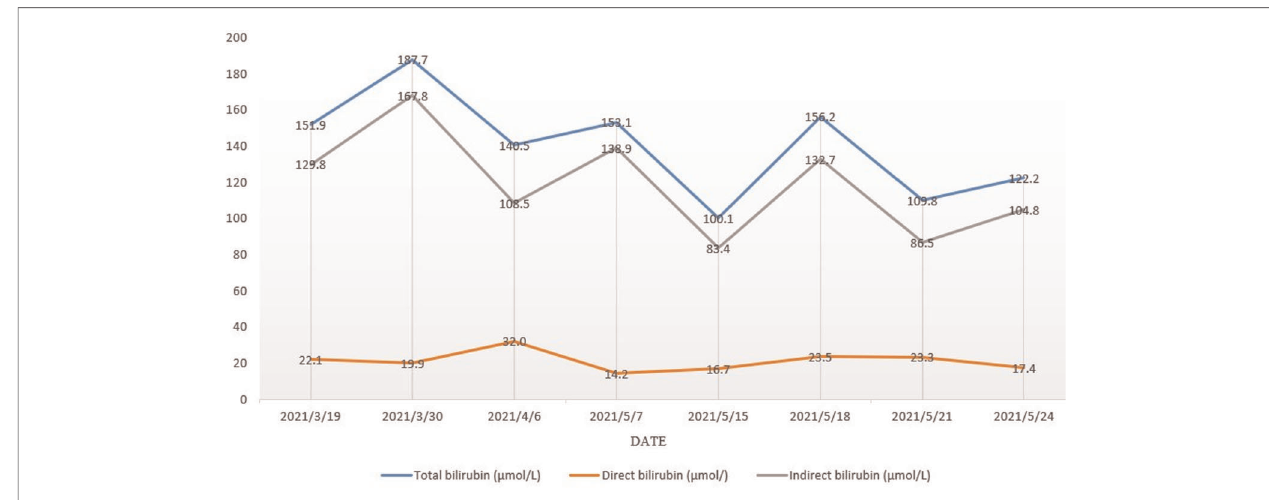
FIGURE 5 | Changes in the bilirubin during